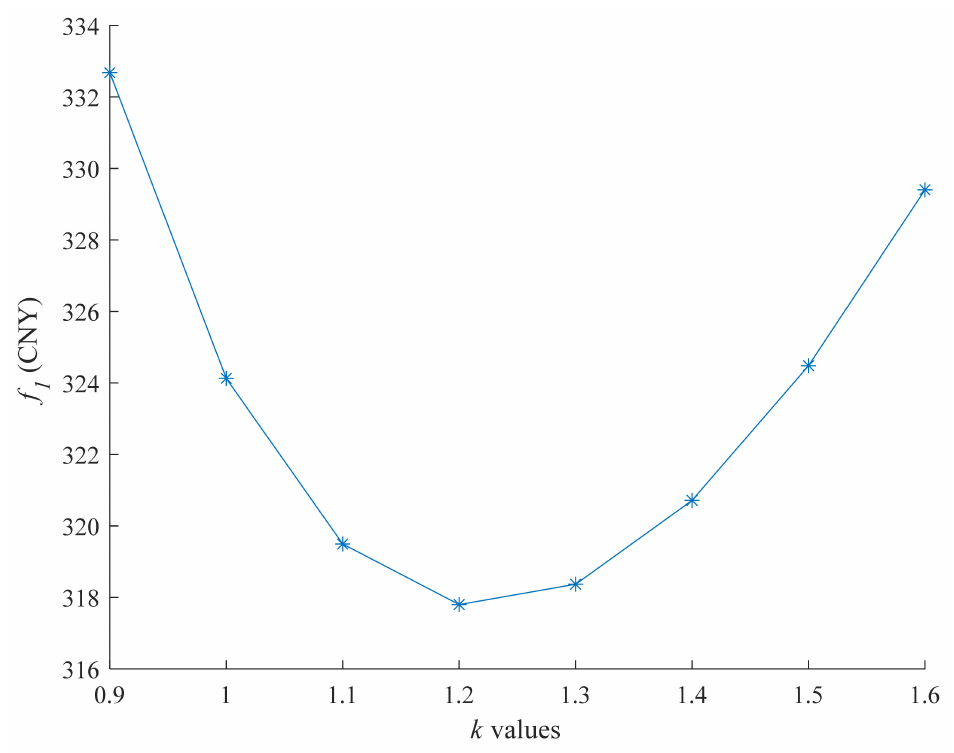
Figure 7. The comparison of f 1 values under different k